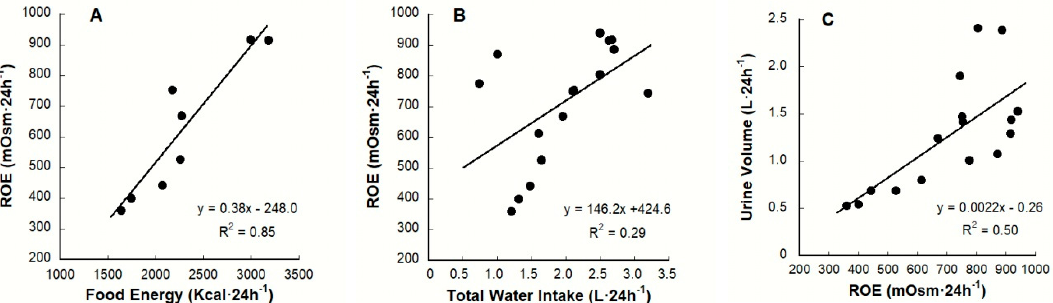
Figure 7. Relationships between 24-h renal osmolar excretion (ROE) and food energy, total water intake and urine volume. Each symbol represents a group mean ( n = 14–682) from the six studies in Table 3. ( A ): the strong relationship between food energy and ROE; ( B ): the weak relationship between TWI and ROE; ( C ): as ROE increases, the obligatory urine volume increases.